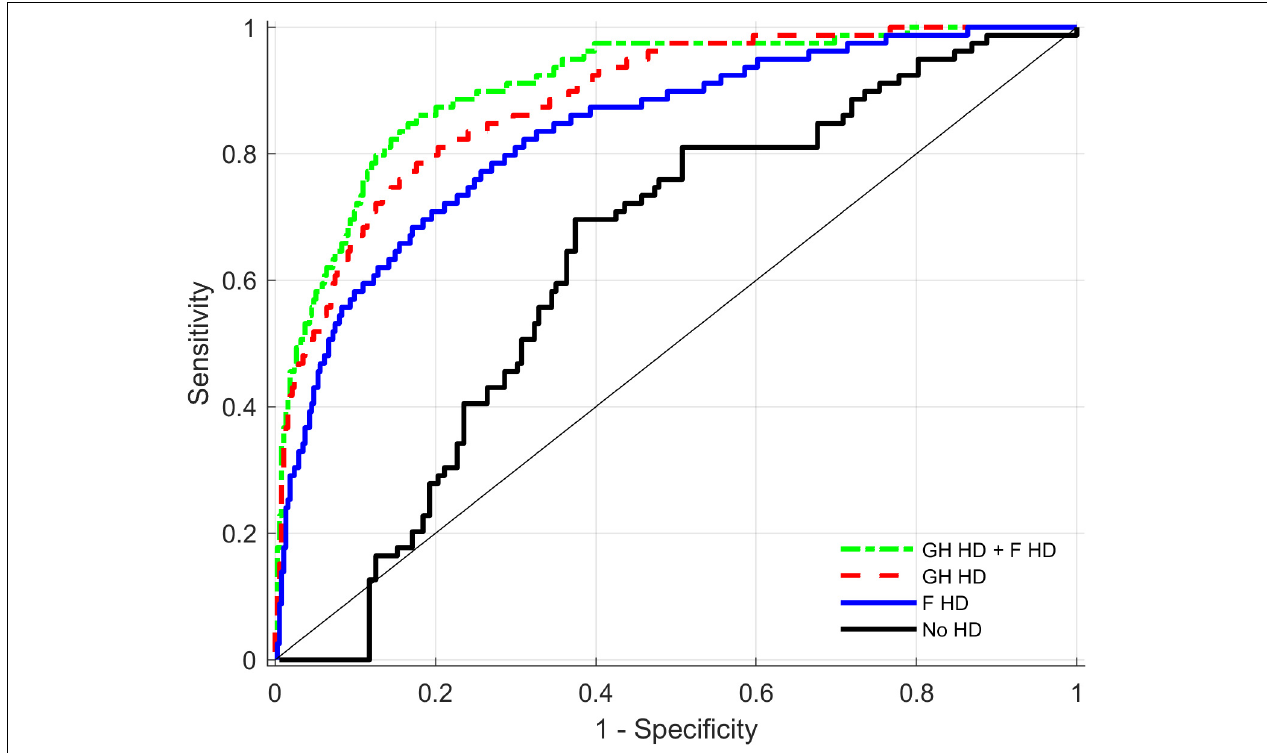
FIGURE 2 | Receiver operating characteristics (ROC) curves for health distances (HD) of General health (GH), Fitness (F), and the combination of both HDs as predictors of Heart Failure. ROC curves present combined output from all imputed datasets (see section “Materials and